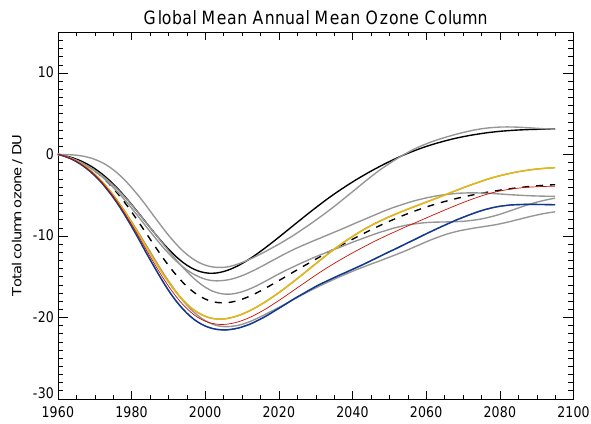
Fig. 1. Multi-model mean smooth trend in ozone for six models (CCSRNIES, CMAM, MRI, SOCOL, ULAQ and WACCM) for the standard REF scenario (black solid line) and for a scenario with fixed greenhouse gas concentrations at 1960 levels (black dashed line). Grey lines show estimate of the multi-model mean trend in the fixed GHG scenario, calculated by adding the shift between the REF and fixed GHG scenario runs to the multi-model mean trend from the REF scenario for each of the six models. Estimates produced using the CCSRNIES (yellow) and WACCM (blue) models are highlighted in colour. The estimate of the multi-model mean calculated by averaging the shift in the CCSRNIES and WACCM models is shown in the red line.